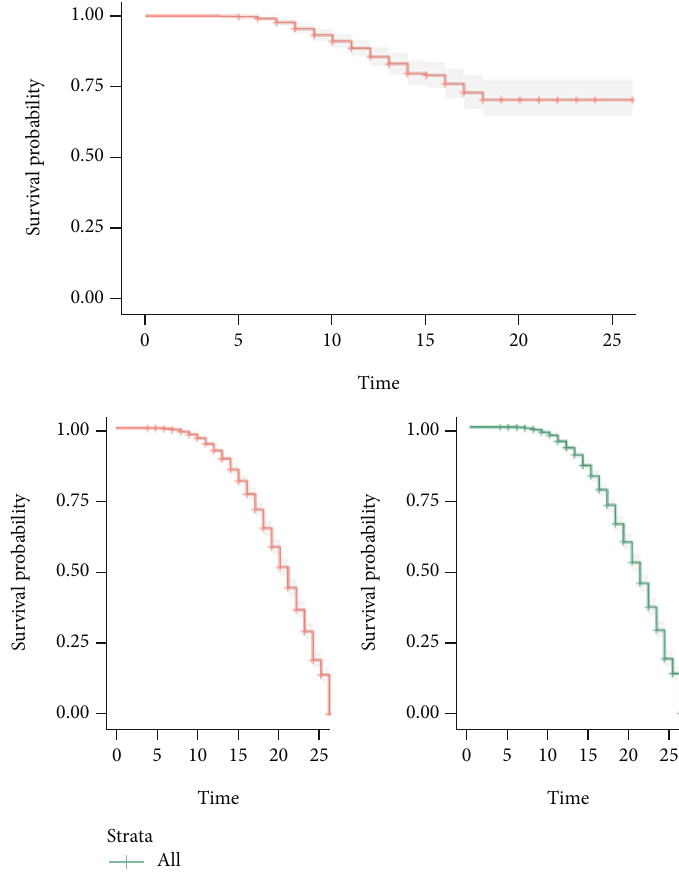
Figure 2: TCGA joint survival curves for the entire